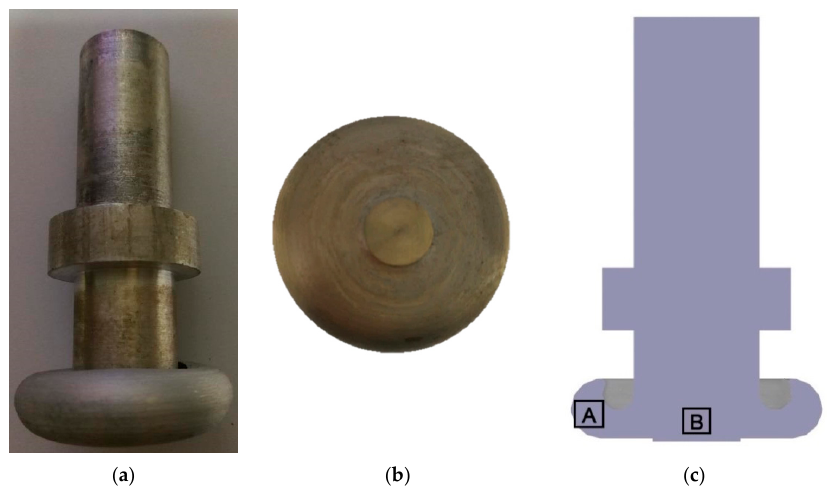
Figure 15. Deformed shape of AA5083 rod. ( a ) front view; ( b ) bottom view; ( c ) cross-section view.